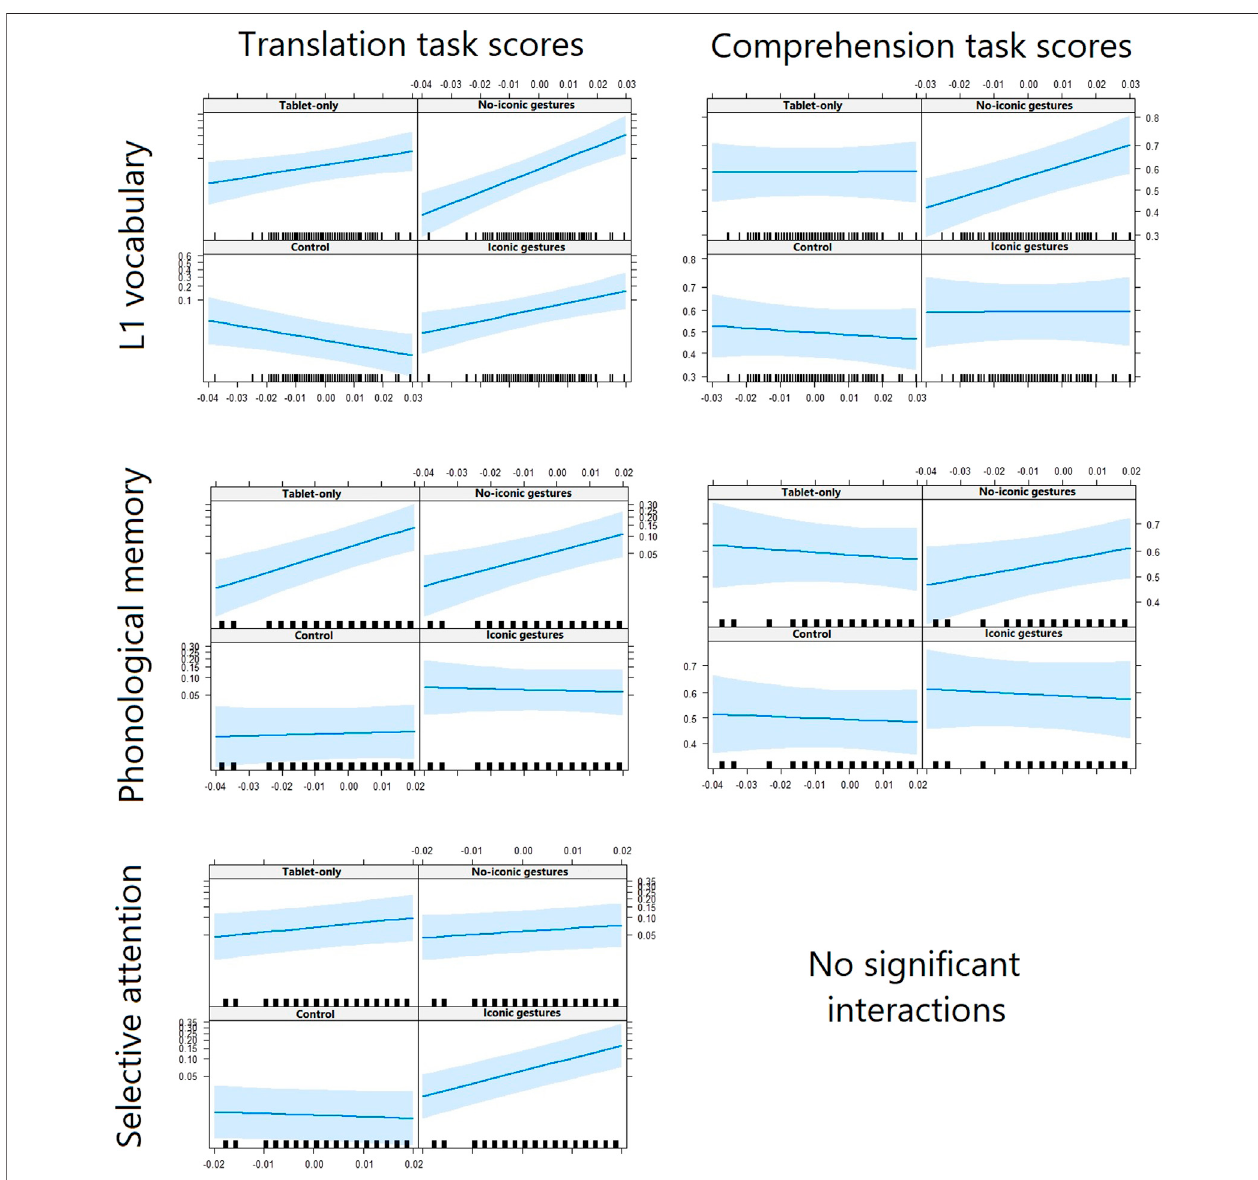
FIGURE 3 | Relations between children ’ s English word-knowledge scores ( y -axis) and (language) learning scores ( x -axis), separated by condition and word- knowledge task.